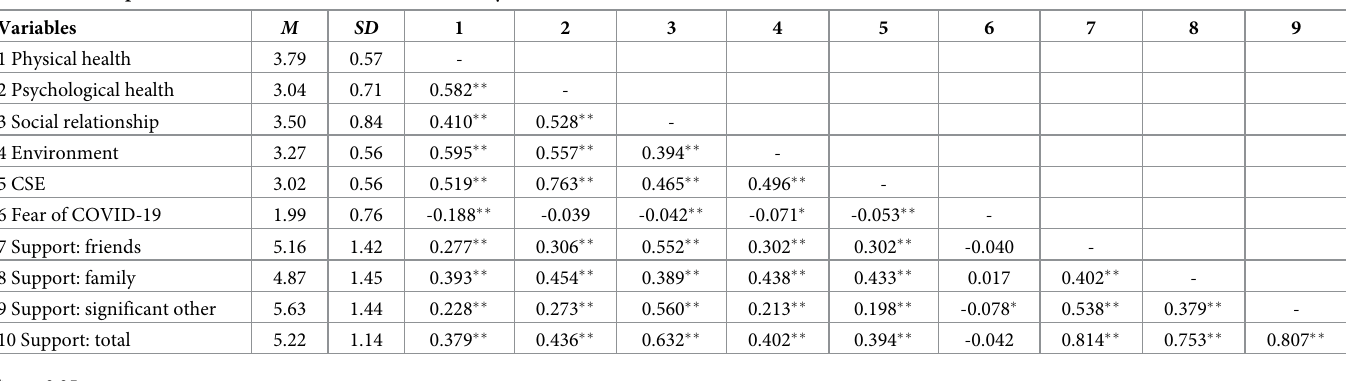
Table 2. Descriptive statistics and correlations between study